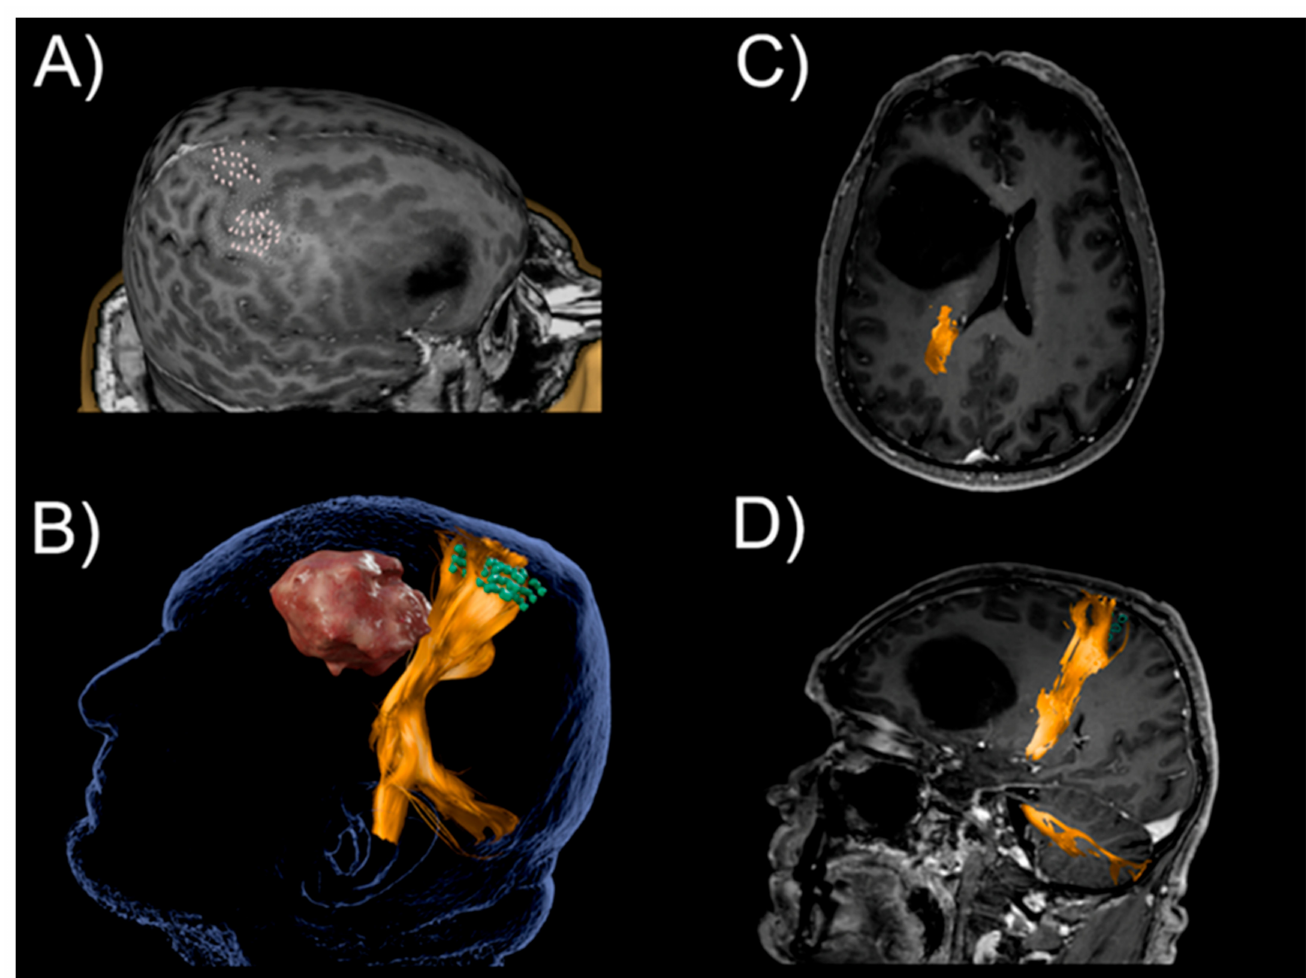
Figure 4. Exemplary patient case (right-hemispheric glioma in a 56-year-old male patient) for illustration of CST reconstruc- tion using tractography based on motor maps derived from motor mapping with nTMS. ( A ) Motor map with binarization into motor-positive ( white ) and motor-negative ( grey ) stimulation points. ( B ) Tractography of the CST ( orange ) based on a ROI constituted of motor-positive nTMS points ( green ). ( C ) Fusion of T1-weighted imaging and tractography results (axial plane). ( D ) Fusion of T1-weighted imaging and tractography results (sagittal